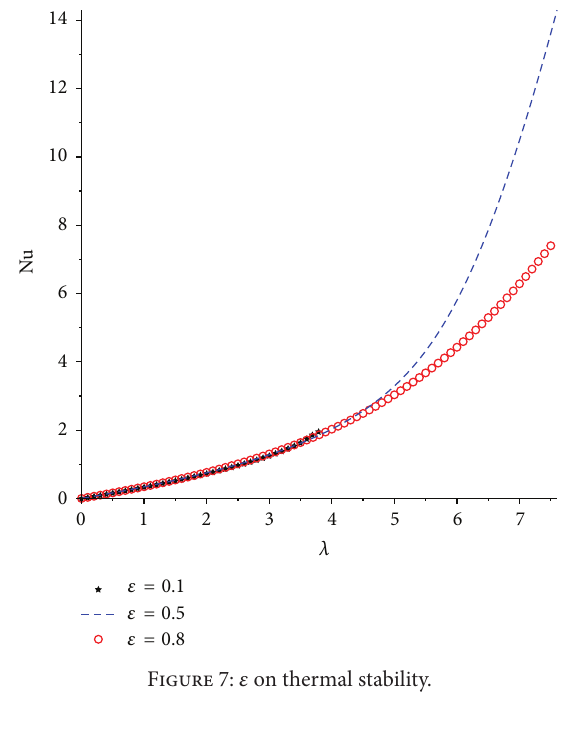
Figure 7: 𝜀 on thermal stability.